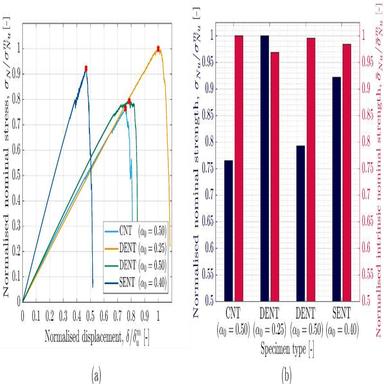
(a) Normalised nominal stress-displacement for all 4 FE models; (b) Normalised nominal and intrinsic nominal strengths.